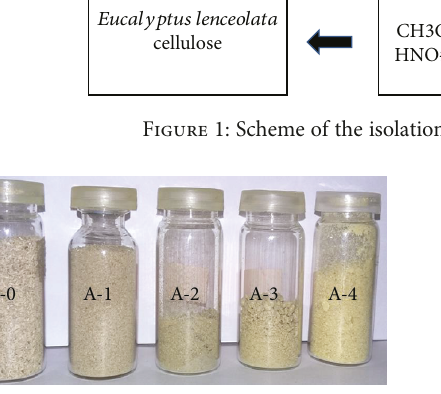
Figure 2: Sample of crude Eucalyptus lenceolata straw (A-0), after the Soxhlet procedure (A-1), after alkaline treatment in an autoclave (A-2), after bleaching-I (A-3), and after bleaching-II (A-4).